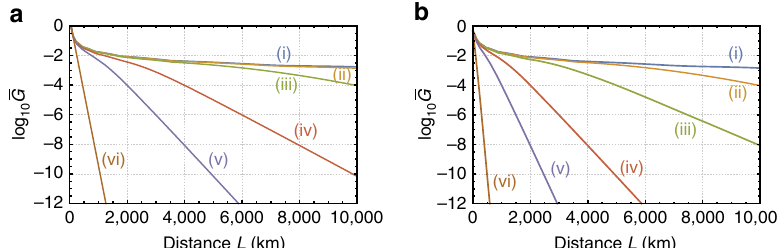
Figure 3 | Upper bounds for DLCZ-type quantum repeaters with time-dependent memory decay. The performance of the protocols 18,23,24,30 is measured in terms of the secret bits or ebits per average total channel use, (cid:2) G : ¼ log 2 d k = (cid:2) m l , for the distance L between Alice and Bob. The protocols use h i k l l repeater nodes { C j } j ¼ 1,2, y ,2 n þ 1 located at regular intervals and connected by optical fibres with transmittance Z l : ¼ e (cid:2) l = l att ( l att ¼ 22km) with each other, as in Fig. 1b. We assume that the coupling efficiency to the fibres is Z c ¼ 0.9 and the speed of light in the fibres is v ¼ 2.0 (cid:4) 10 8 ms (cid:2) 1 . The source nodes { C 2 j } j ¼ 1,2, y , n are assumed to be equipped with matter quantum memories with dephasing, whose coherence time is (i) t c ¼ 1.0 (cid:4) 10 (cid:2) 2 s, (ii) t c ¼ 5.0 (cid:4) 10 (cid:2) 3 s, (iii) t c ¼ 2.5 (cid:4) 10 (cid:2) 3 s, (iv) t c ¼ 1.0 (cid:4) 10 (cid:2) 3 s, (v) t c ¼ 5.0 (cid:4) 10 (cid:2) 4 s and (vi) t c ¼ 1.0 (cid:4) 10 (cid:2) 4 s. The upper bounds for the protocols